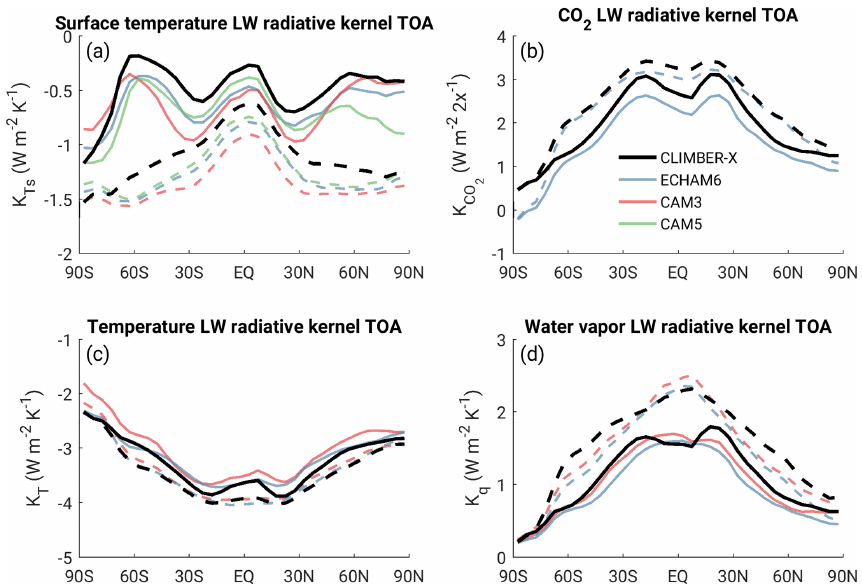
Figure A6. Longwave radiative kernels at the top of the atmosphere for (a) surface temperature warming by 1K, (b) atmospheric CO 2 doubling, (c) air temperature warming by 1K and (d) water vapour increase corresponding to 1K warming in the atmosphere. The kernels computed using the CLIMBER-X radiation code are compared to kernels available from different climate models (Shell et al., 2008; Block and Mauritsen, 2013; Pendergrass et al., 2018). Solid lines are for total-sky conditions, while dashed lines are for clear-sky conditions. Table A8. Effect of removing different longwave absorbers on the net longwave absorbed by the circa 1980 atmosphere. The unit is Wm − 2 . The reference values are from Schmidt et al.